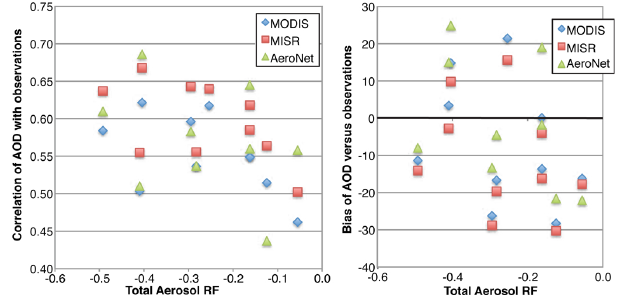
Fig. 9. Comparison of model skill in capturing the spatial pattern and seasonal cycle (left) or magnitude of annual average (right, per- cent) AOD observations with modeled RF due to all